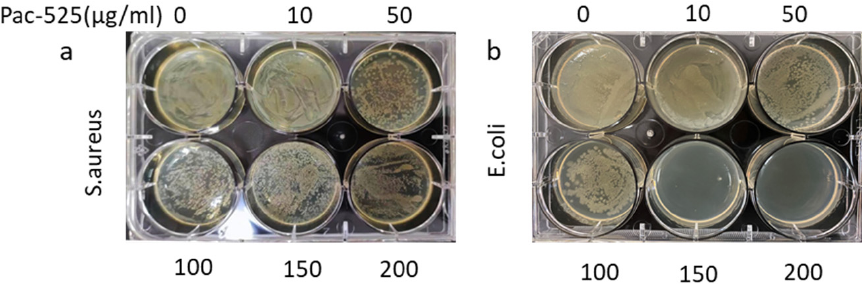
Figure 5. The antibacterial activity of Pac-525 was evaluated with the area of bacteria on agar plate. ( a ) S. aureus was inhibited by Pac-525 at the concentration of 50 µ g/mL. ( b ) E. coli was inhibited by Pac-525 at the concentration of 50 µ g/mL.